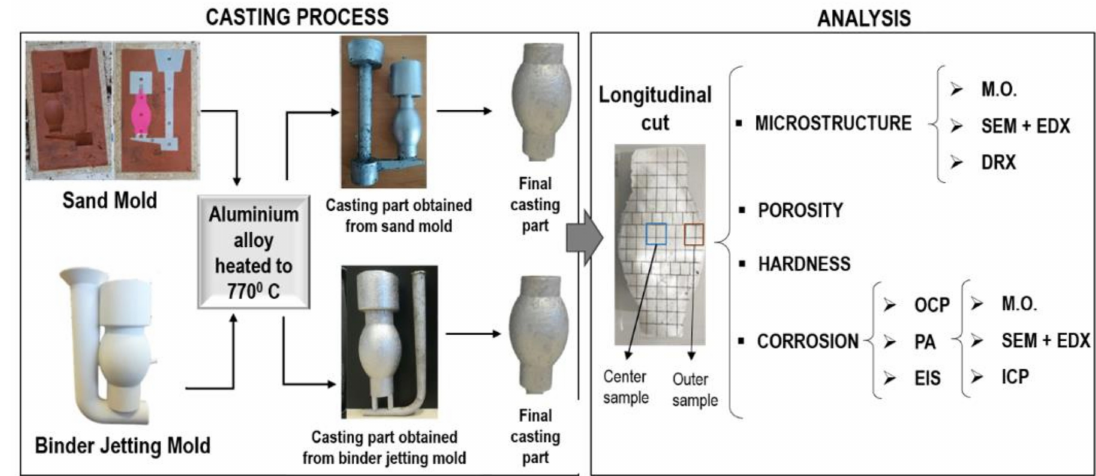
Figure 1. The methodology used for the casting process and analysis of the casting samples (metallographic and corro- sion